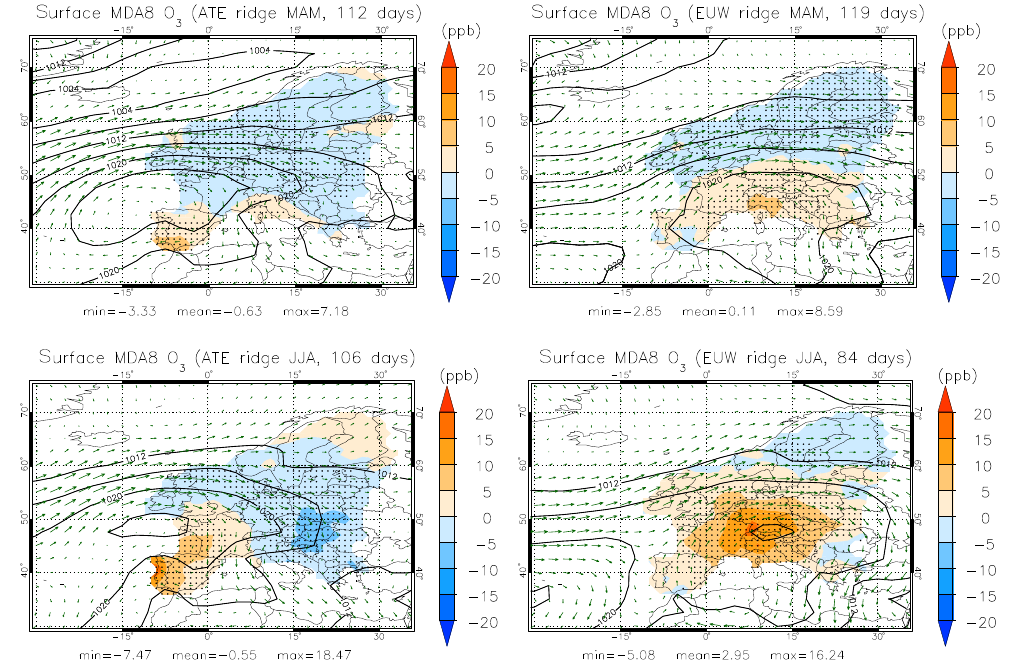
Figure 8. As Fig. 4 but for subtropical ridges with centres over the east Atlantic (15–0 ◦ W, left) and the west of the EUR sector (0–15 ◦ E, right) in spring (top) and summer (bottom).